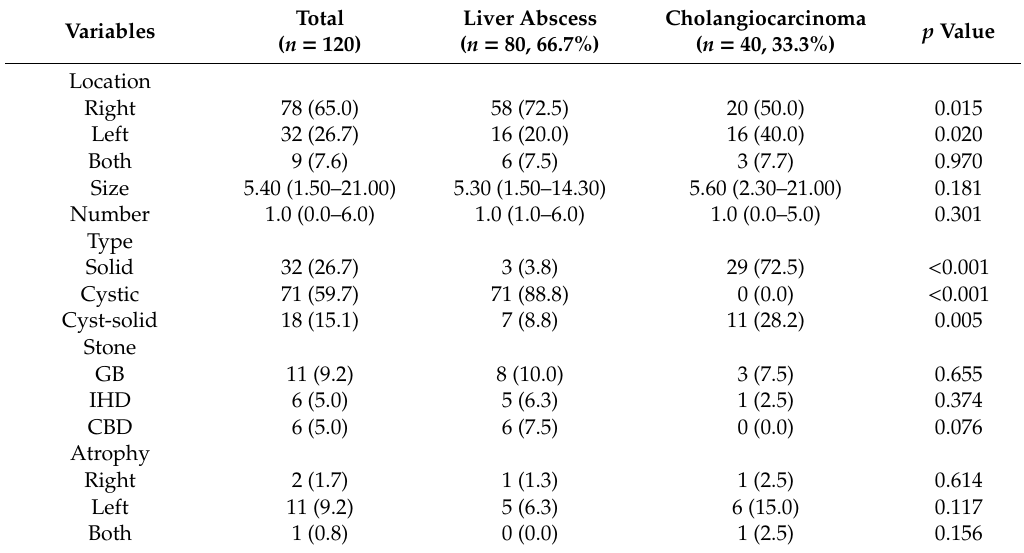
Table 2. Characteristics of computed tomography of liver abscess and cholangiocarcinoma.